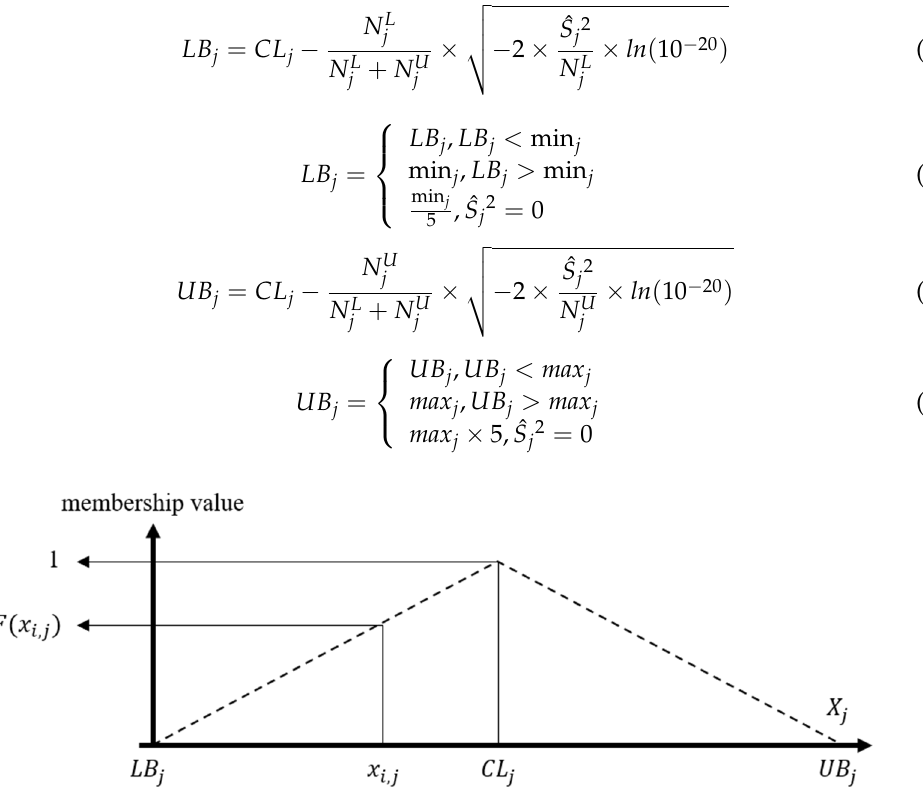
Figure 3. The possible population range of MTD.